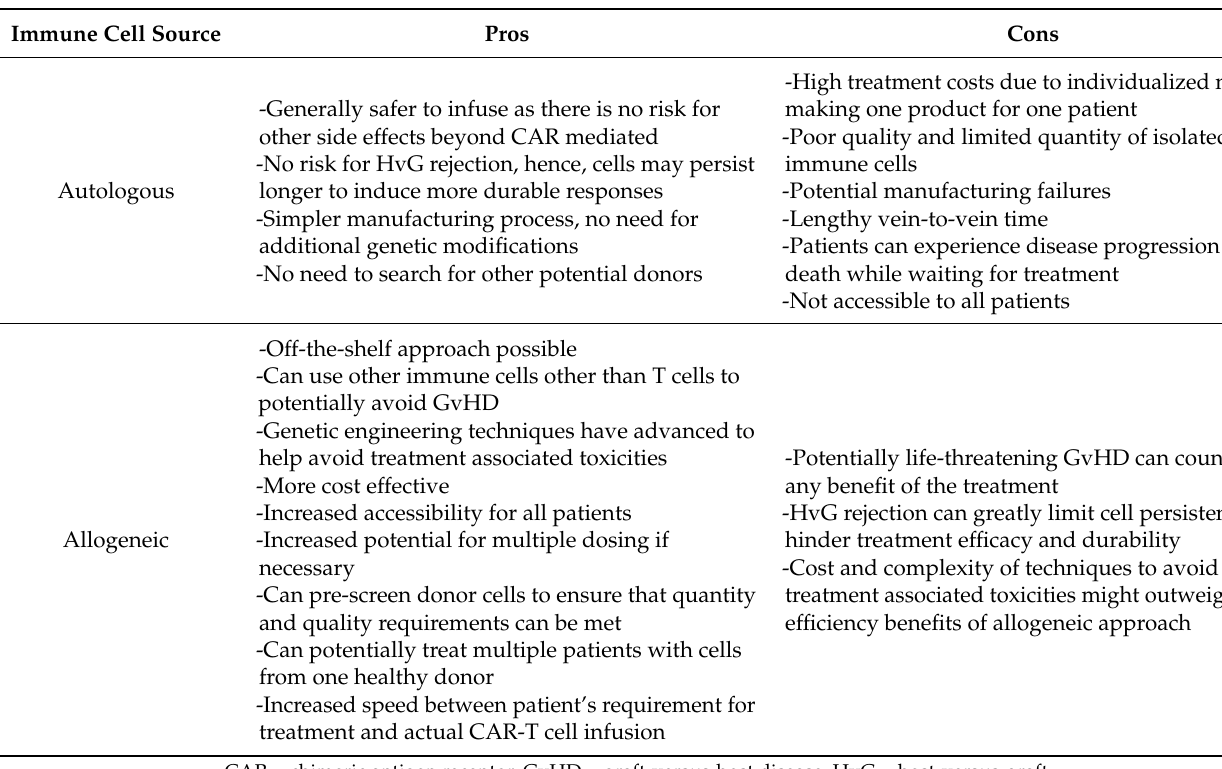
Table 3. Pros and cons of autologous and allogeneic CAR-T